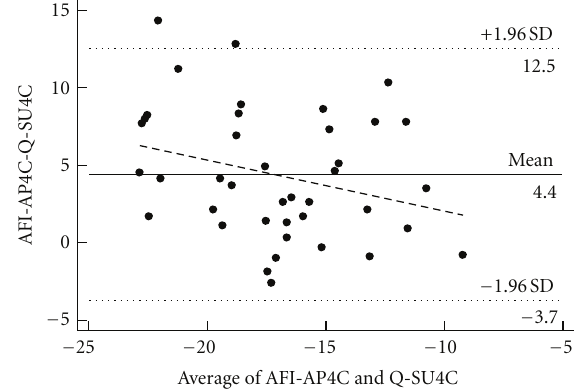
Figure 3: Bland Altman plot with mean di ff erence and limits of agreement between Q-analysis of global peak systolic strain from the subcostal 4-chamber view (Q-SU4C) view compared to AFI global peak systolic strain (AFI-AP4C).